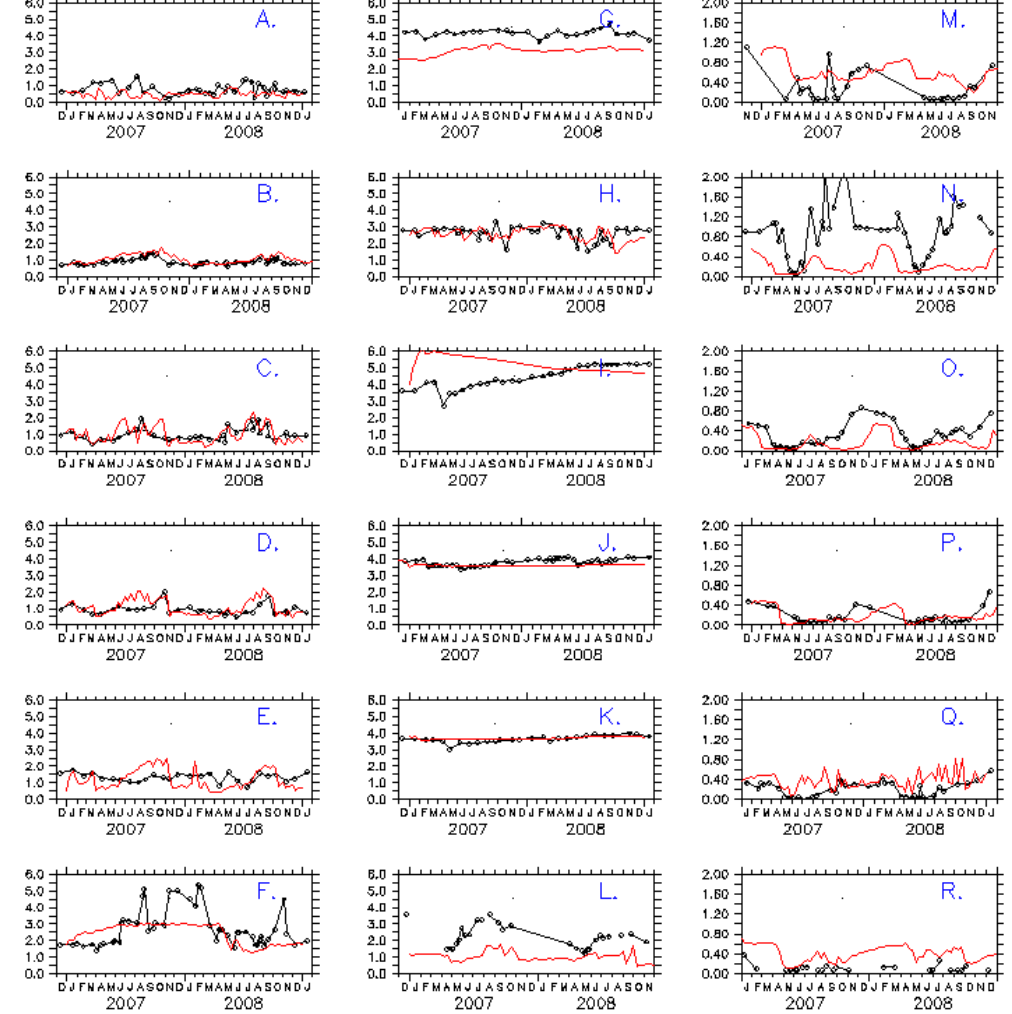
Fig. 9. Seasonal variability of DIP in bottom layer. Notations same as in Fig.